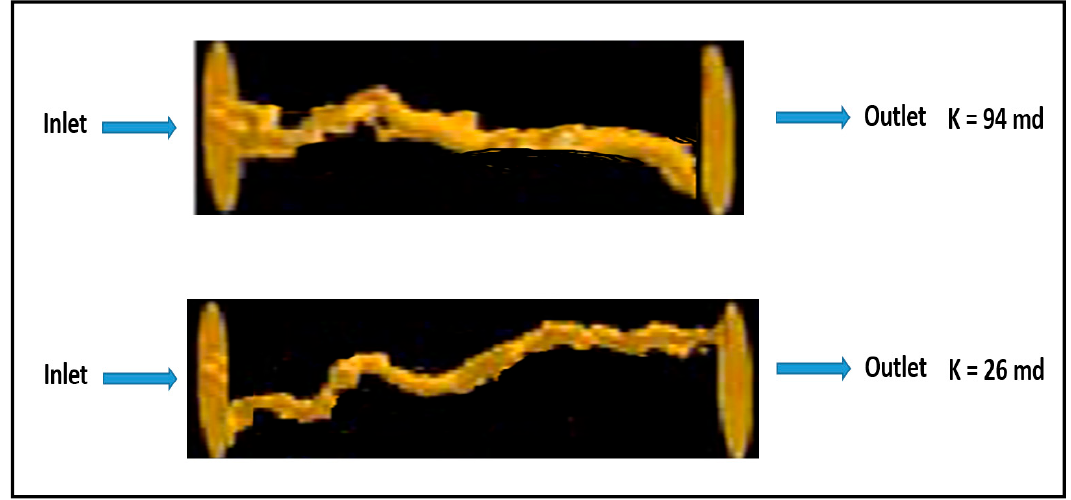
Figure 2. CT-scan images for the rock samples after diverting the injected acid using a thermochemical approach.